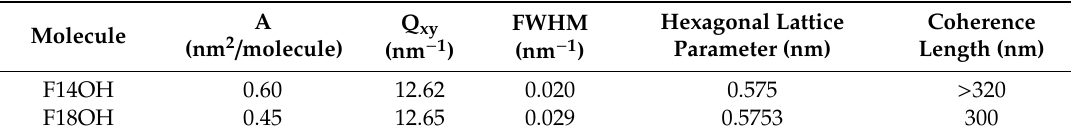
Figure 2. Di ff raction spectra at 18 ◦ C of the Langmuir films of F14OH ( left ) and F18OH ( right ) at di ff erent surface areas along the zero surface pressure plateau. Table 2. Peak position (Q xy ) and full width at half maximum (FWHM) of the di ff raction peaks presented in Figure 2, obtained by fitting Lorentzian curves to the GIXD